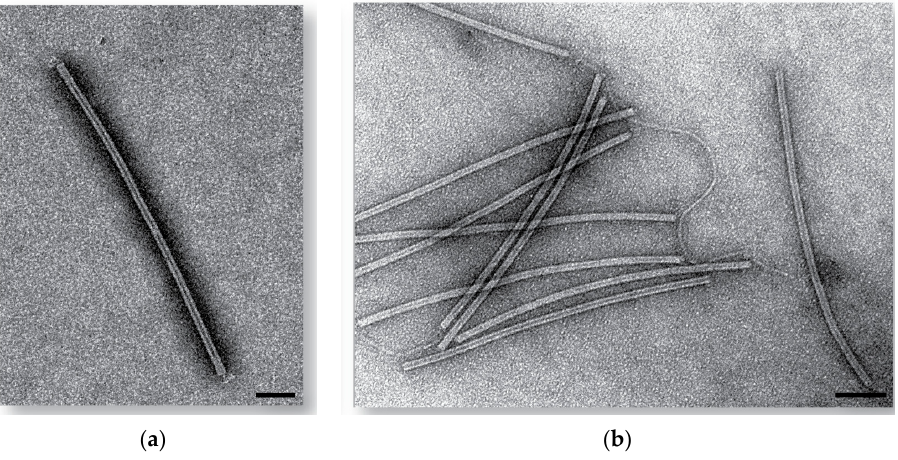
Figure 1. Electron Micrographs of Sulfolobus islandicus rod-shaped viruses SIRV5 ( a ) and SIRV8 ( b ) stained with 2% uranyl acetate. Scale bar 100 nm.